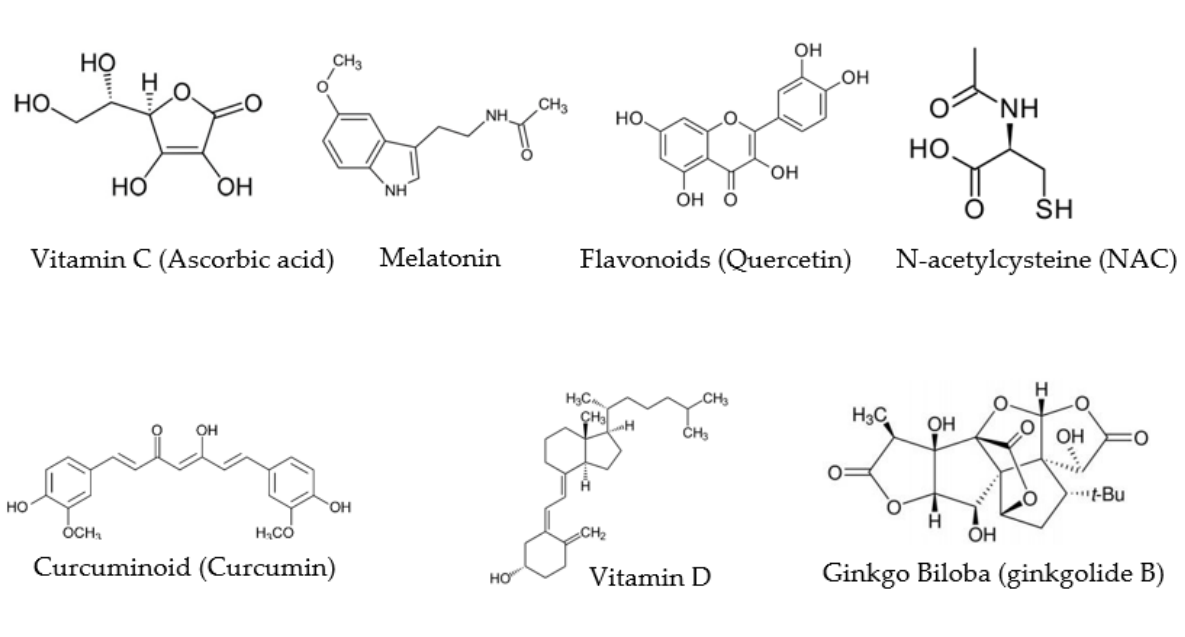
Figure 4. Summary of different nanosystem types employed for drug encapsulation to overcome the limitations of antioxidant delivery in neuronal regeneration from post-COVID-19 damages. Examples of organic delivery vehicles include liposomes, cubosomes, solid lipid nanoparticles, micelles, and polymeric nanoparticles. Examples of inorganic nanoparticles include nanoceria, mesoporous silica nanoparticles, and iron oxide NPs. Carbon-based materials, which lack carbon– hydrogen bonds typical of organic compounds, include various types of nanostructures (e.g., car- bon nanotubes, graphene nanosheets, and fullerenes). The properties of the different nanocarriers are described in the text. Solid lipid nanoparticles (SLNs) are widely known transporters of chemotherapeu- tic agents to the CNS [37]. These matrix-type lipid particles, usually consisting of fatty acids or mono-, di-, or triglycerides, remain with a solid core at body temperature. Cubosomes are liquid crystalline nanostructures created from cubic-phase-forming li- pids, such as monoolein and phytantriol [29,35,38], which have the unique ability to dis- perse into nanoparticles that are stable upon dilution [57–59]. Liposomes and cubosomes can encapsulate hydrophobic drugs in the lipid bilayer membranes and hydrophilic compounds in the aqueous compartments [29,35,37]. Polymeric nanoparticles are particles with sizes between 5 and 1000 nm. They can be loaded with active substances, which are either surface-adsorbed onto the polymeric matrix core or entrapped within. The various biodegradable polymers commonly used in the fabrication of polymeric nanoparticles include poly(lactide) (PLA), poly(lactide- co-glycolide) (PLGA) copolymers, poly ( ɛ -caprolactone) (PCL), and poly(amino acids), as well as some natural polymers such as alginate, chitosan, and gelatin [30,60–62]. Inorganic nanoparticles are primarily known for their use in diagnostic and theranostic applications. Iron oxide nanoparticles (IONPs) are one type of inorganic NPs that has been extensively employed for therapeutic and diagnostic imaging since the 1960s. Gold nanoparticles (AuNPs) have been widely studied due to their biocompatibil- ity and the ease of controlling their size distribution and shape. AuNPs can take a varie- ty of shapes, including spheres, nanorods, and cubes, among others. Other inorganic na-